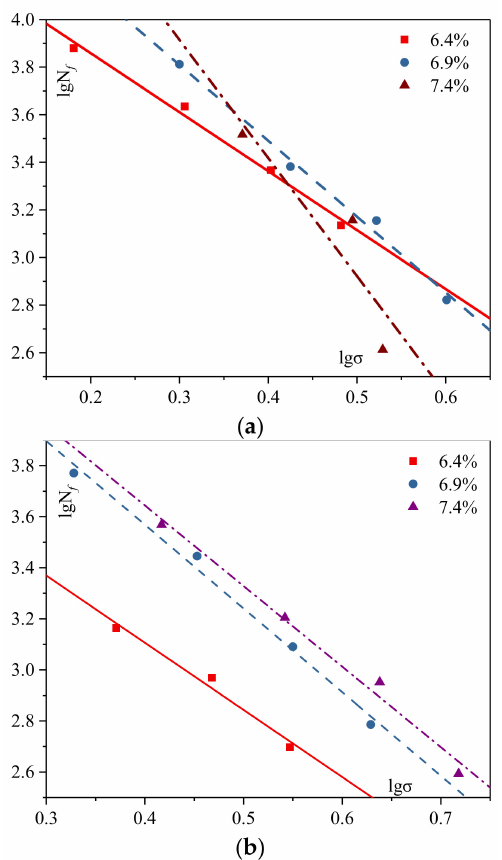
Figure 4. Curves for mixtures with di ff erent additives: ( a ) mixtures with no additives; ( b ) mixtures with Granular Polymer Durable additive